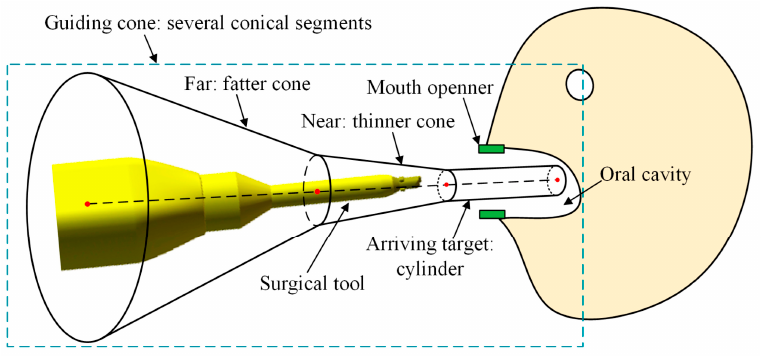
Figure 4. Design of the guiding cone.